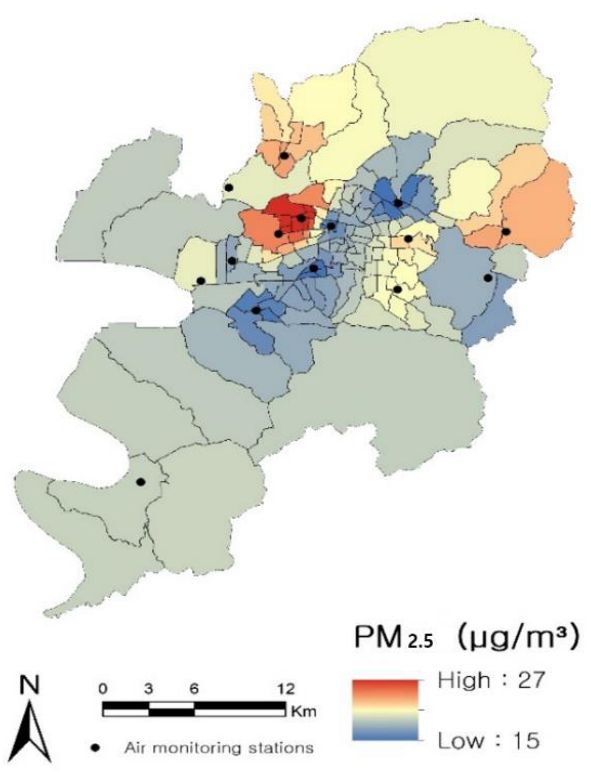
Figure 3. Spatial distribution of PM 2.5.